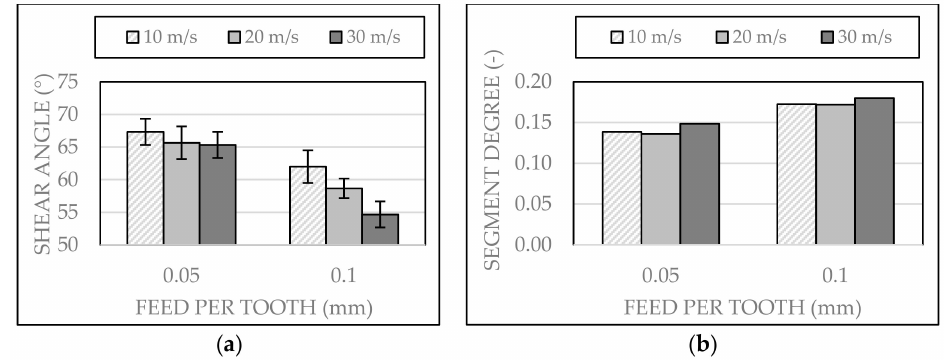
Figure 10. E ff ect of the cutting parameters on the ( a ) shear angle and ( b )segment degree for a workpiece produced by